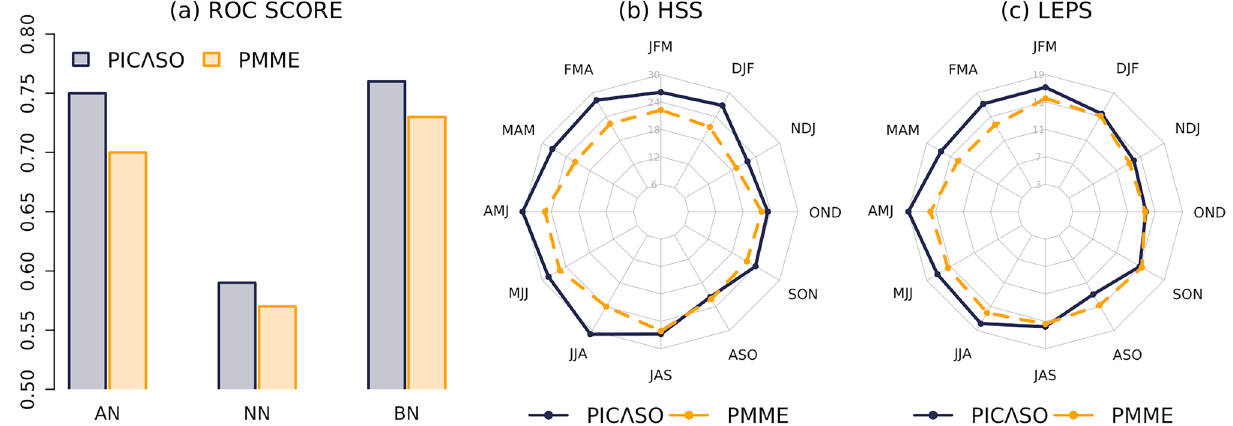
Figure 2. ( a ) Three categories’ ROC scores; and ( b ) HSS and ( c ) LEPS of PICASO and APCC-PMME over 12 seasons for all 49 stations during the training period